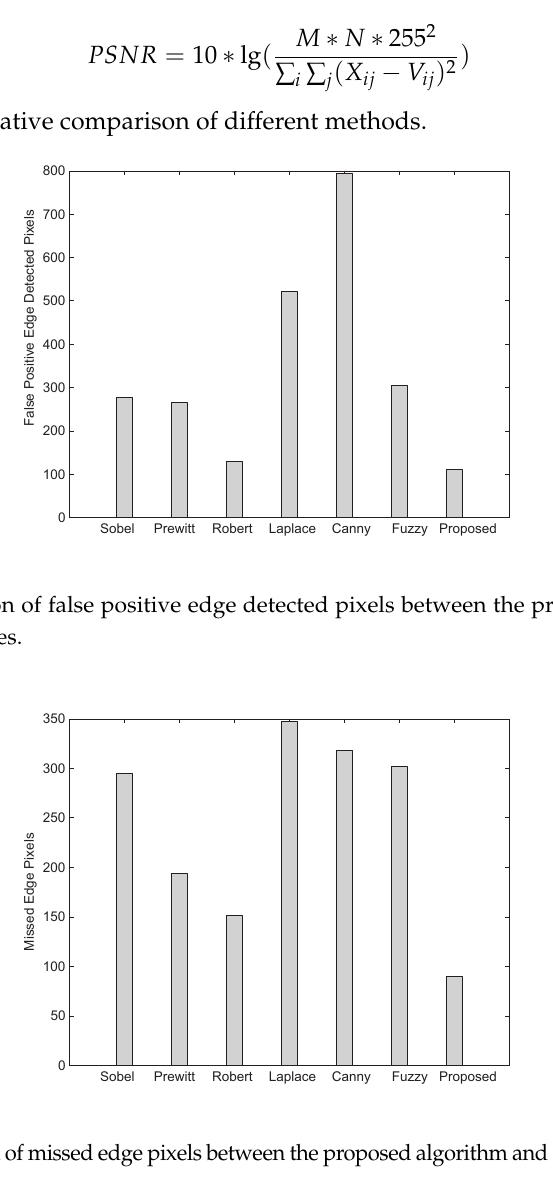
Figure 13. Comparison of missed edge pixels between the proposed algorithm and other conventional ones.